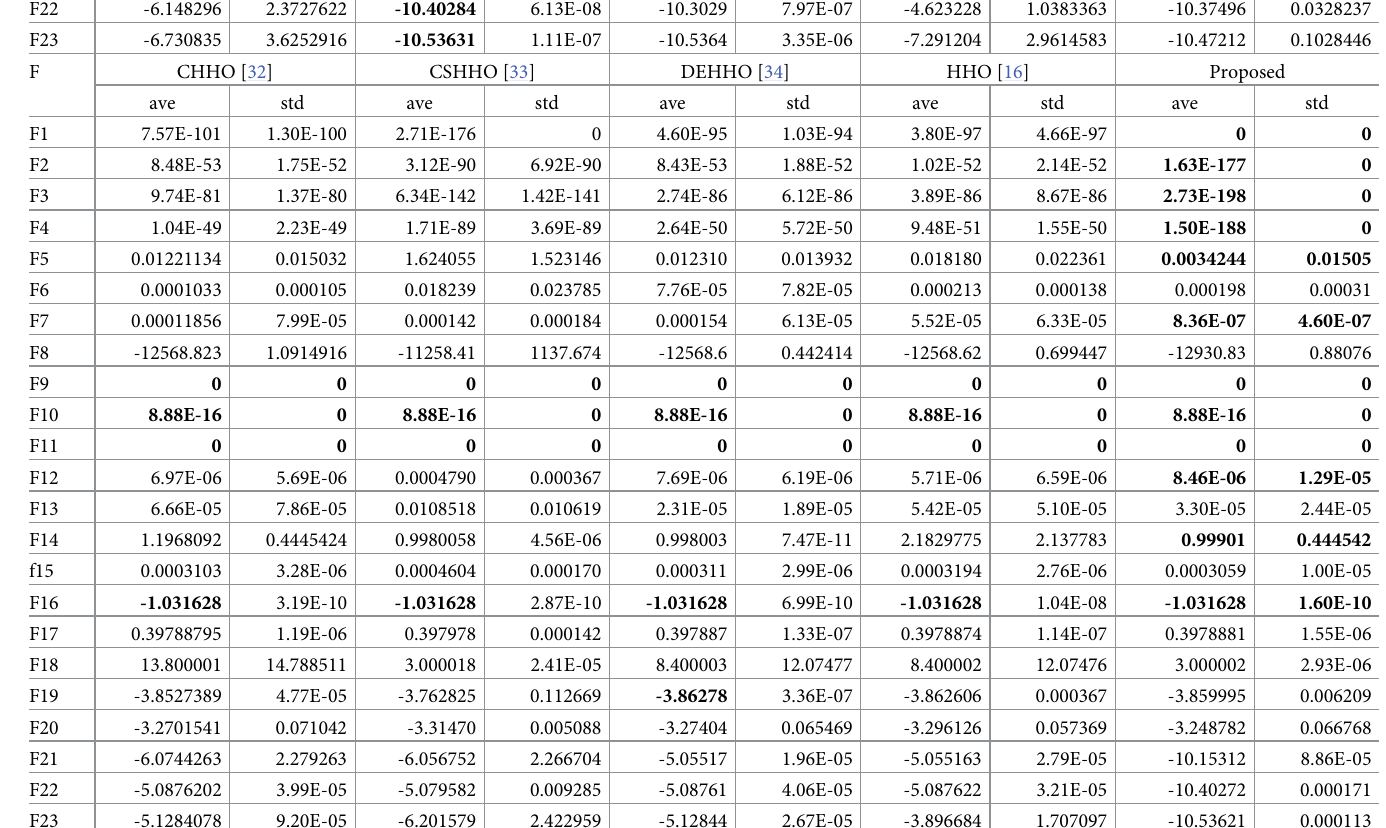
4.1.2. Evaluation of exploration capability (F8-F23). The multimodal functions